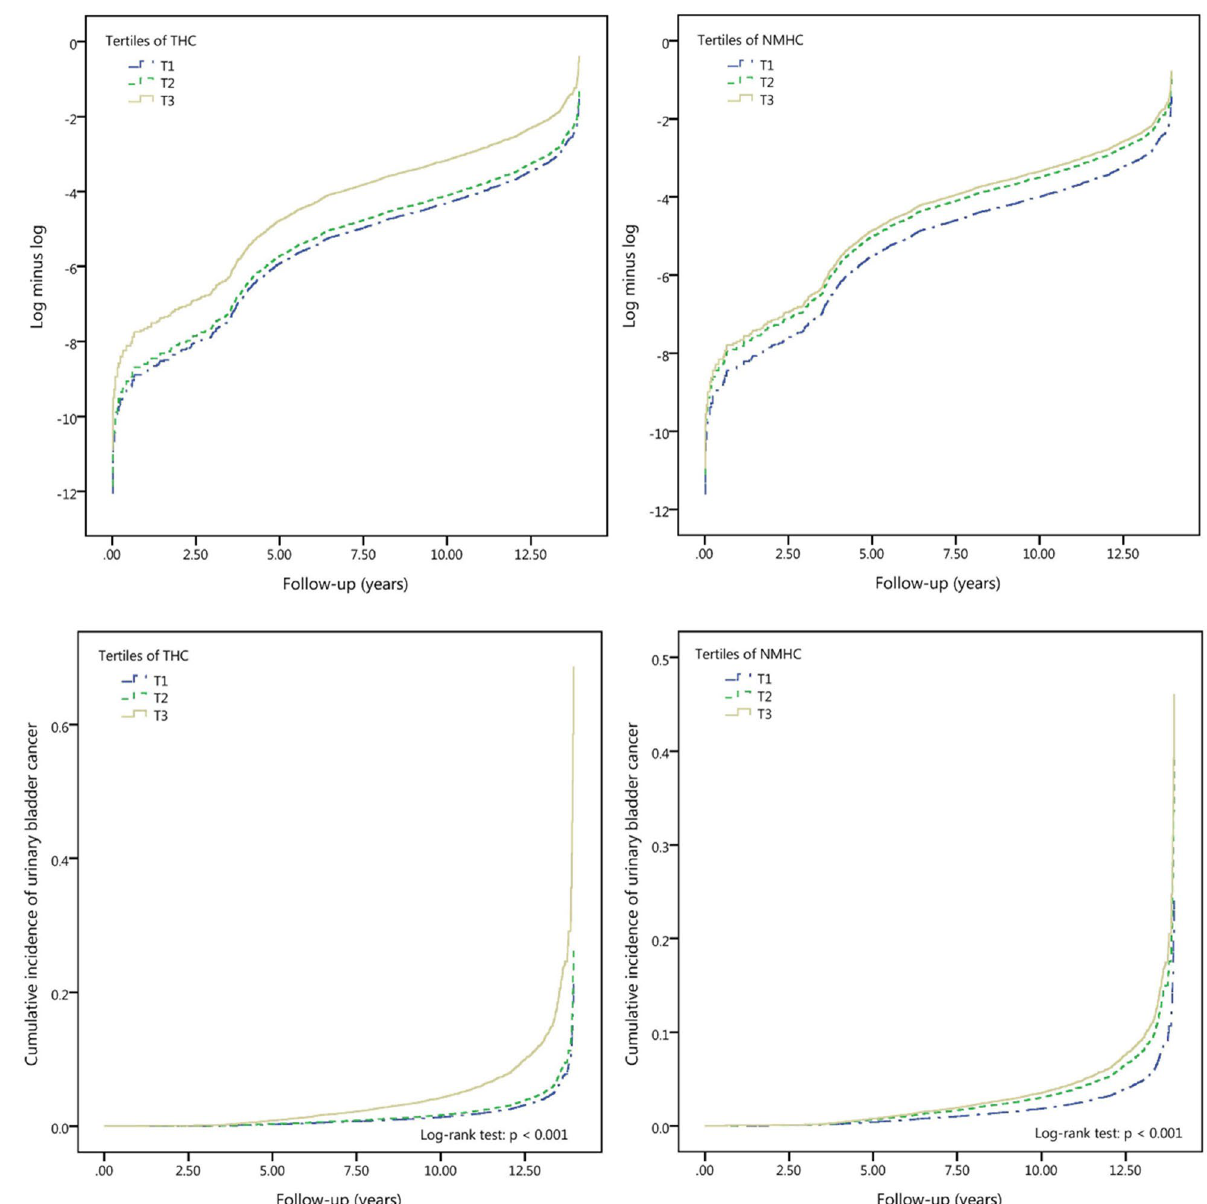
Figure 2. The log minus log survival plot by ambient air THC and NMHC pollutants, and the cumulative incidence of urinary bladder cancer in individuals among THC and NMHC pollutants’ tertile. Upper panel: To evaluate the proportional hazards (PH) assumption involving the comparison of estimated − ln (− ln) survival curves over different THC and NMHC tertiles, the plot of log (− log [survival function]) versus survival time in THC and NMHC air pollutants was constructed. The graphical approach showing parallel curves over time provides support of the PH assumption. Lower panel: Cumulative incidence of urinary bladder cancer for individuals among tertiles of THC and NMHC pollutants. The tertile values, in ppm (THC, NMHC), are as follows: THC (lowest tertile, T1: < 2.10; medium tertile, T2: ≥ 2.10 and < 2.25; and highest tertile, T3: ≥ 2.25); NMHC (lowest tertile, T1: < 0.26; medium tertile, T2: ≥ 0.26 and < 0.34; and highest tertile, T3: ≥